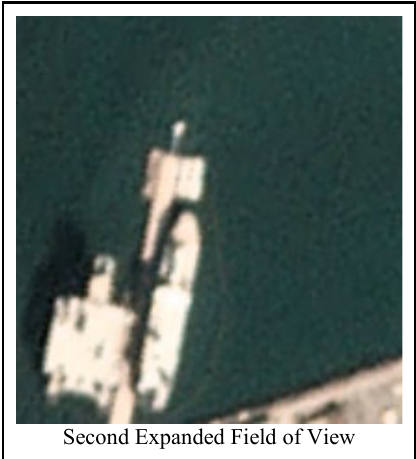
Figure 11. Example of expanding field of view for context clarification